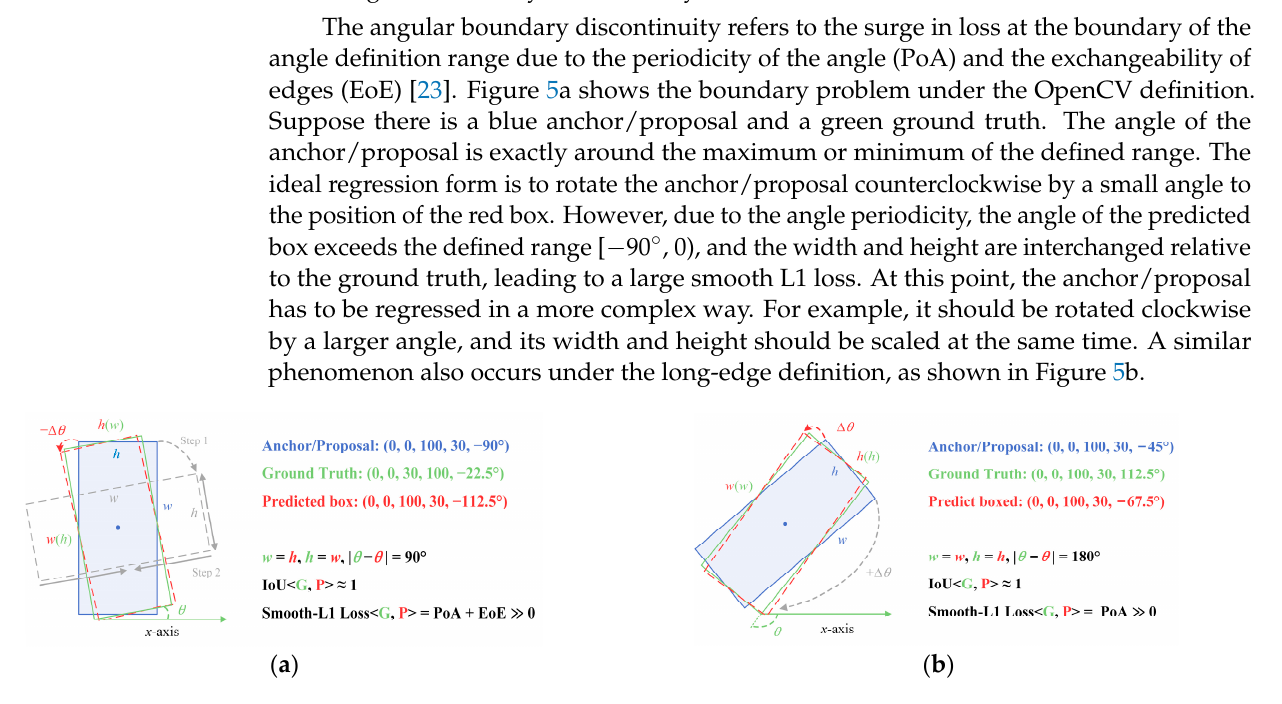
Figure 5. Angular boundary discontinuity under ( a ) the OpenCV definition and ( b ) the long-edge definition.